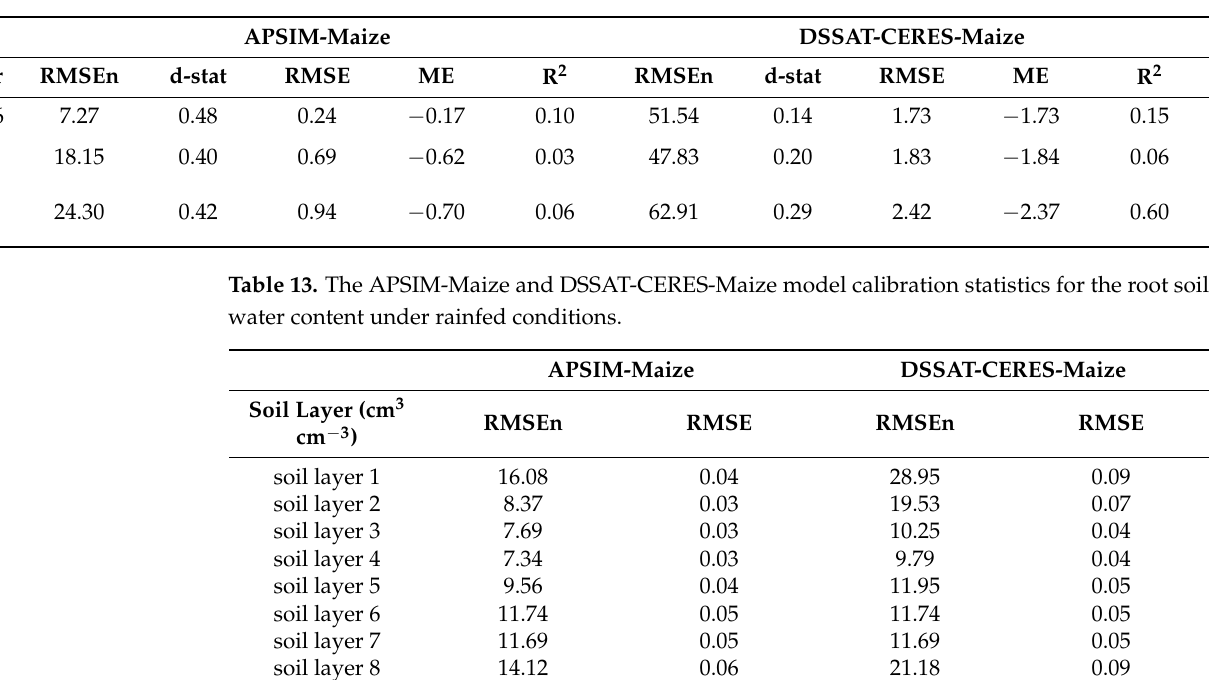
Table 12. The APSIM-Maize and DSSAT-CERES-Maize model calibration statistics for mLAI for the maize cultivars under rainfed conditions.